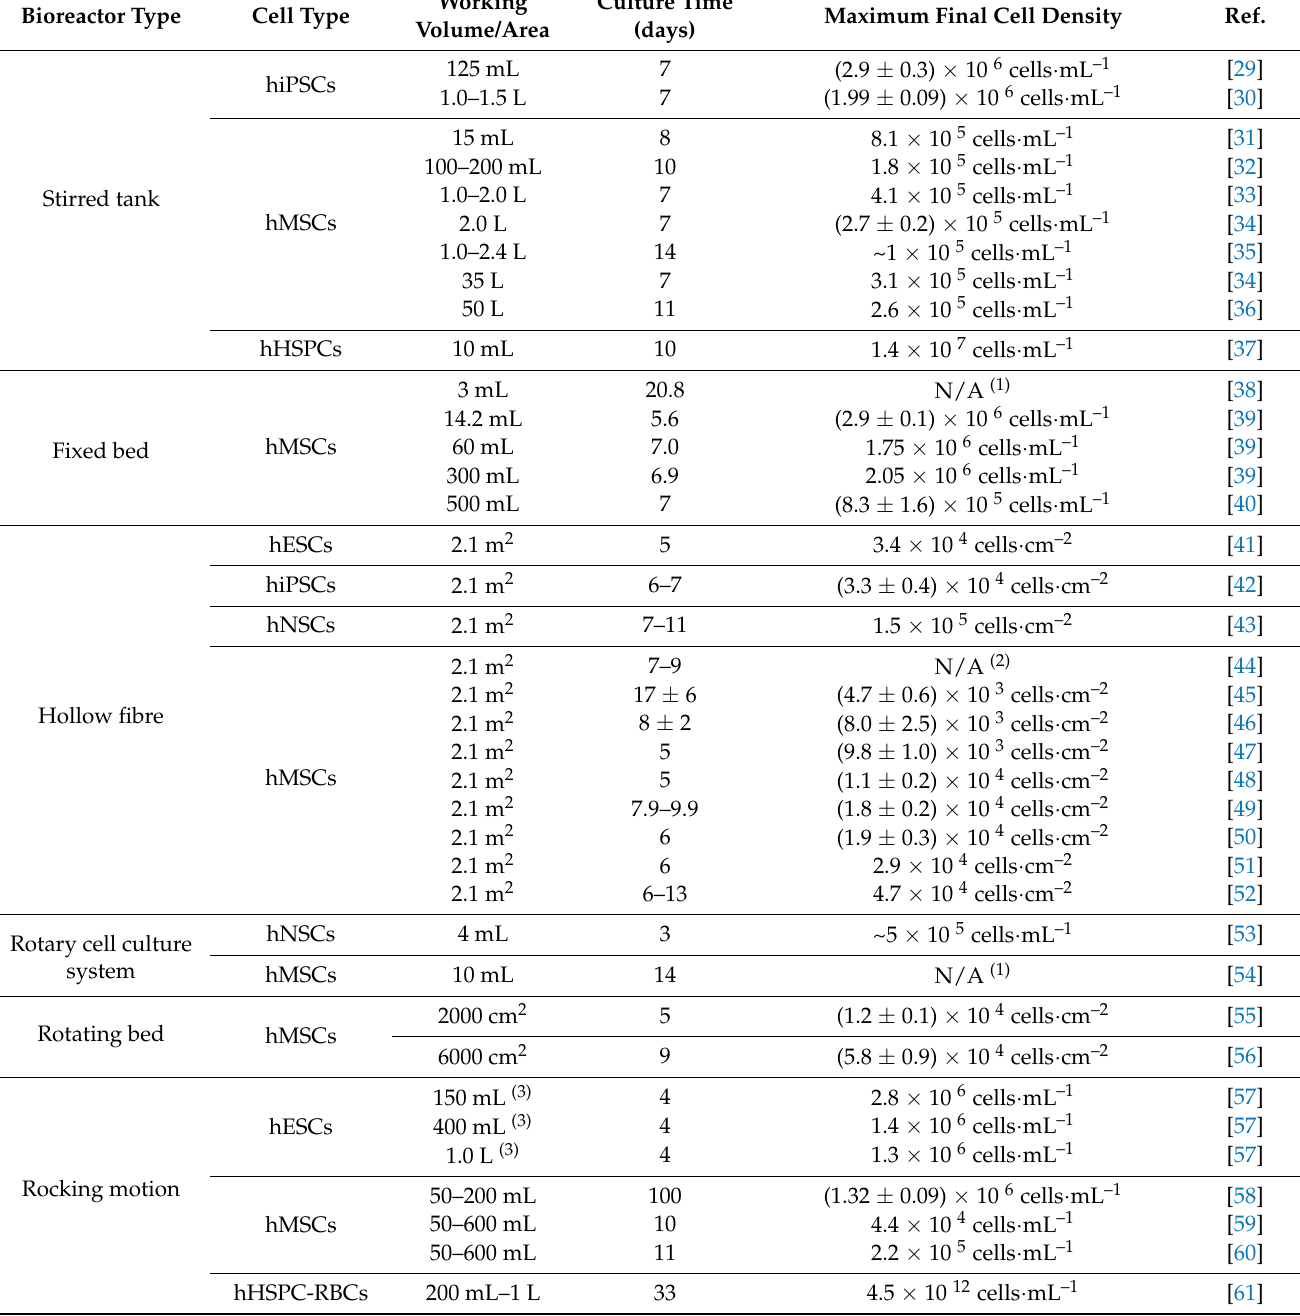
Table 1. Comparison of single-use bioreactor systems for stem cell culture. Working volume ranges indicate a change in volume during the culture. Final cell densities presented are the maximum average obtained among different conditions and/or donors: hESC—human embryonic stem cell; hHSPC—human haematopoietic stem/progenitor cell; hiPSC—human induced pluripotent stem cell; hMSC—human mesenchymal stromal cell; hNSC—human neural stem cell; RBC—red blood